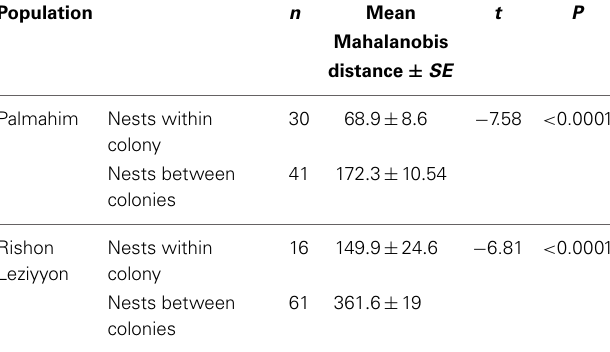
Significance was tested using t-test for unpaired data with unequal variance.